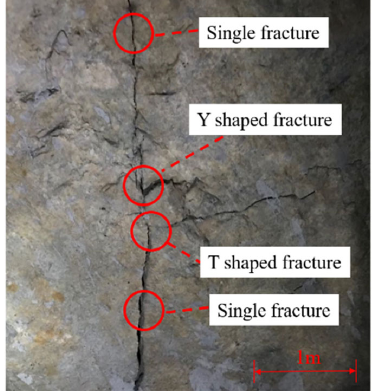
Figure 3. Underground fractured rock mass.